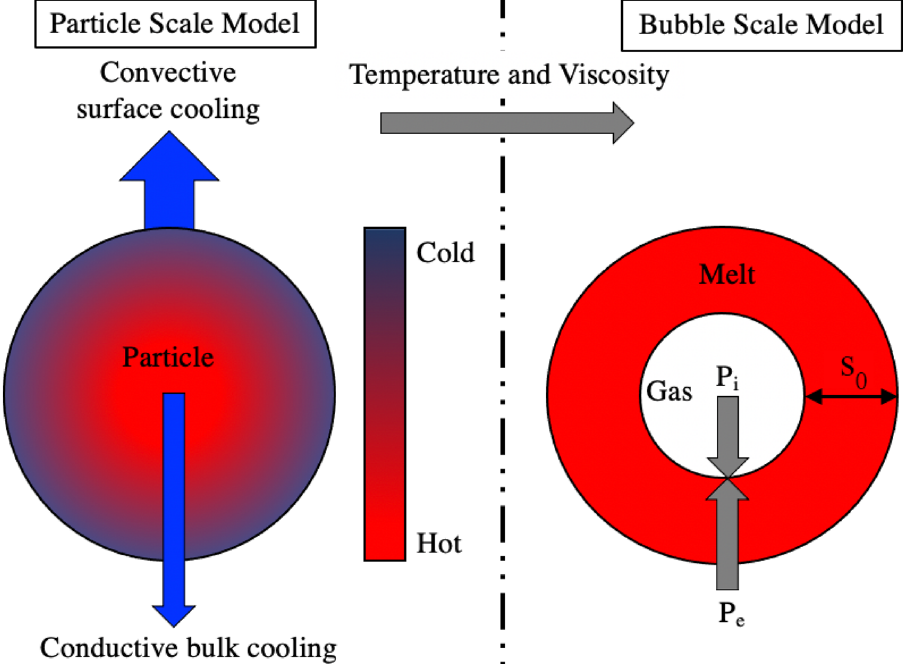
Figure 5. Schematic outlining the physical processes at each scale of the model. Particle-scale: the cooling of the isotropic, spherical particle from convective heat transfer to the surrounding environment and conductive cooling within the particle. Bubble-scale: The bubble growth model in which growth is limited by viscosity and halted once the temperature is lower then the glass transition